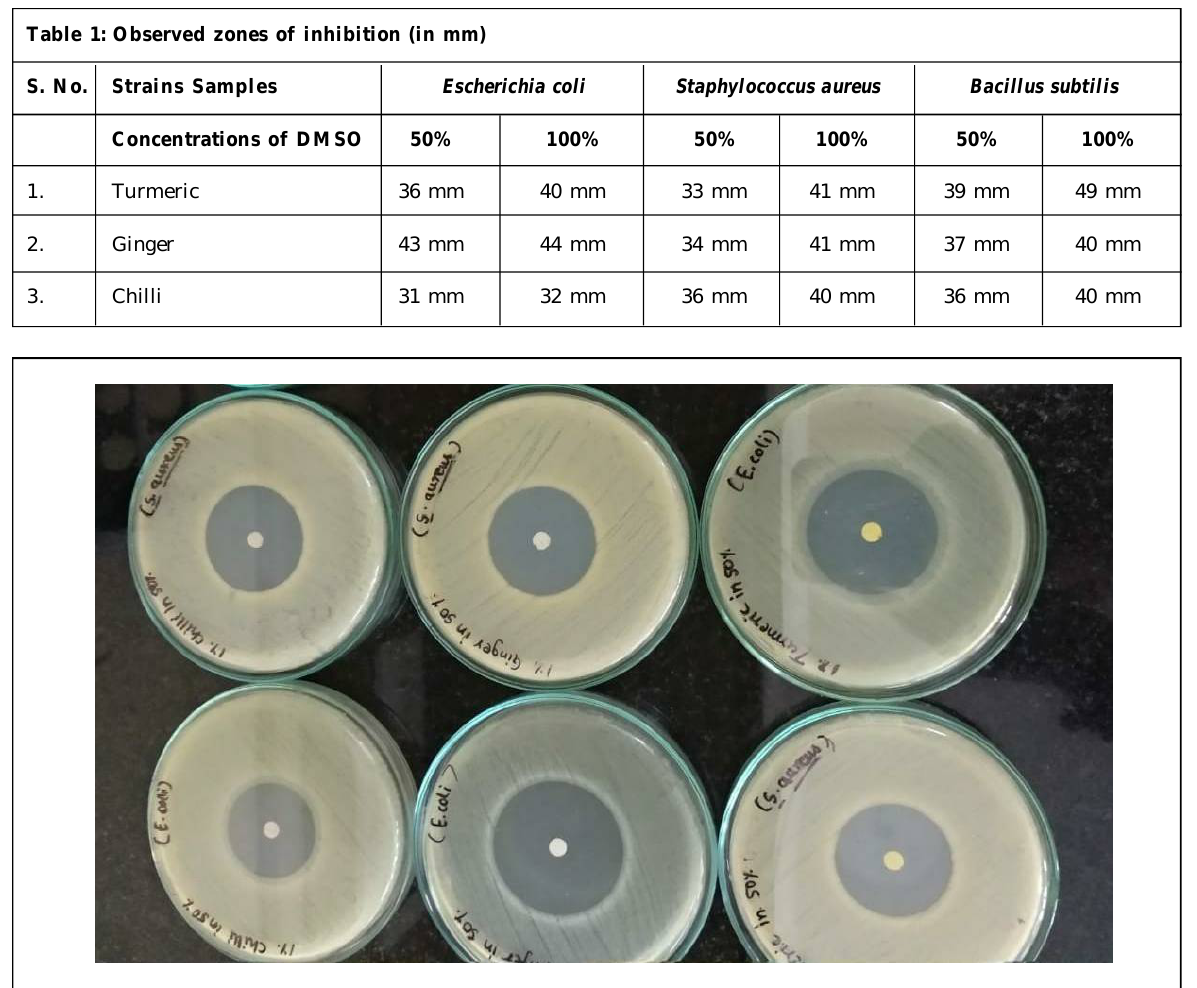
Table 1: Observed zones of inhibition (in mm) S. No.